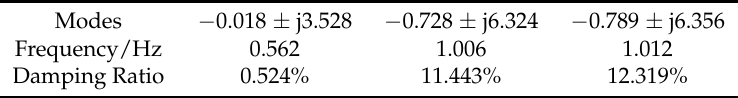
Table 1. Modes Characteristics under the basic operation mode.